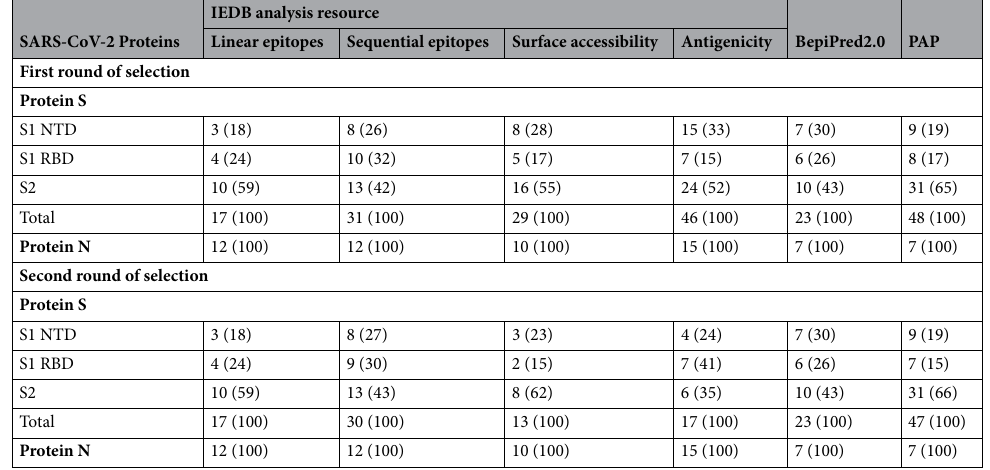
Table 1. Number of immunogenic and antigenic peptides localized in each type of software used. PAP predicted antigenic